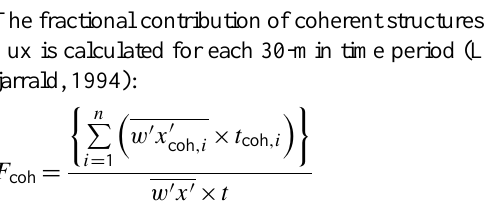
Figure 6. Probability distribution function of the average duration of coherent structures (in seconds) for the Q-H (gray) and wavelet (black) methods under stable (dashed lines) and unstable (solid lines) conditions.